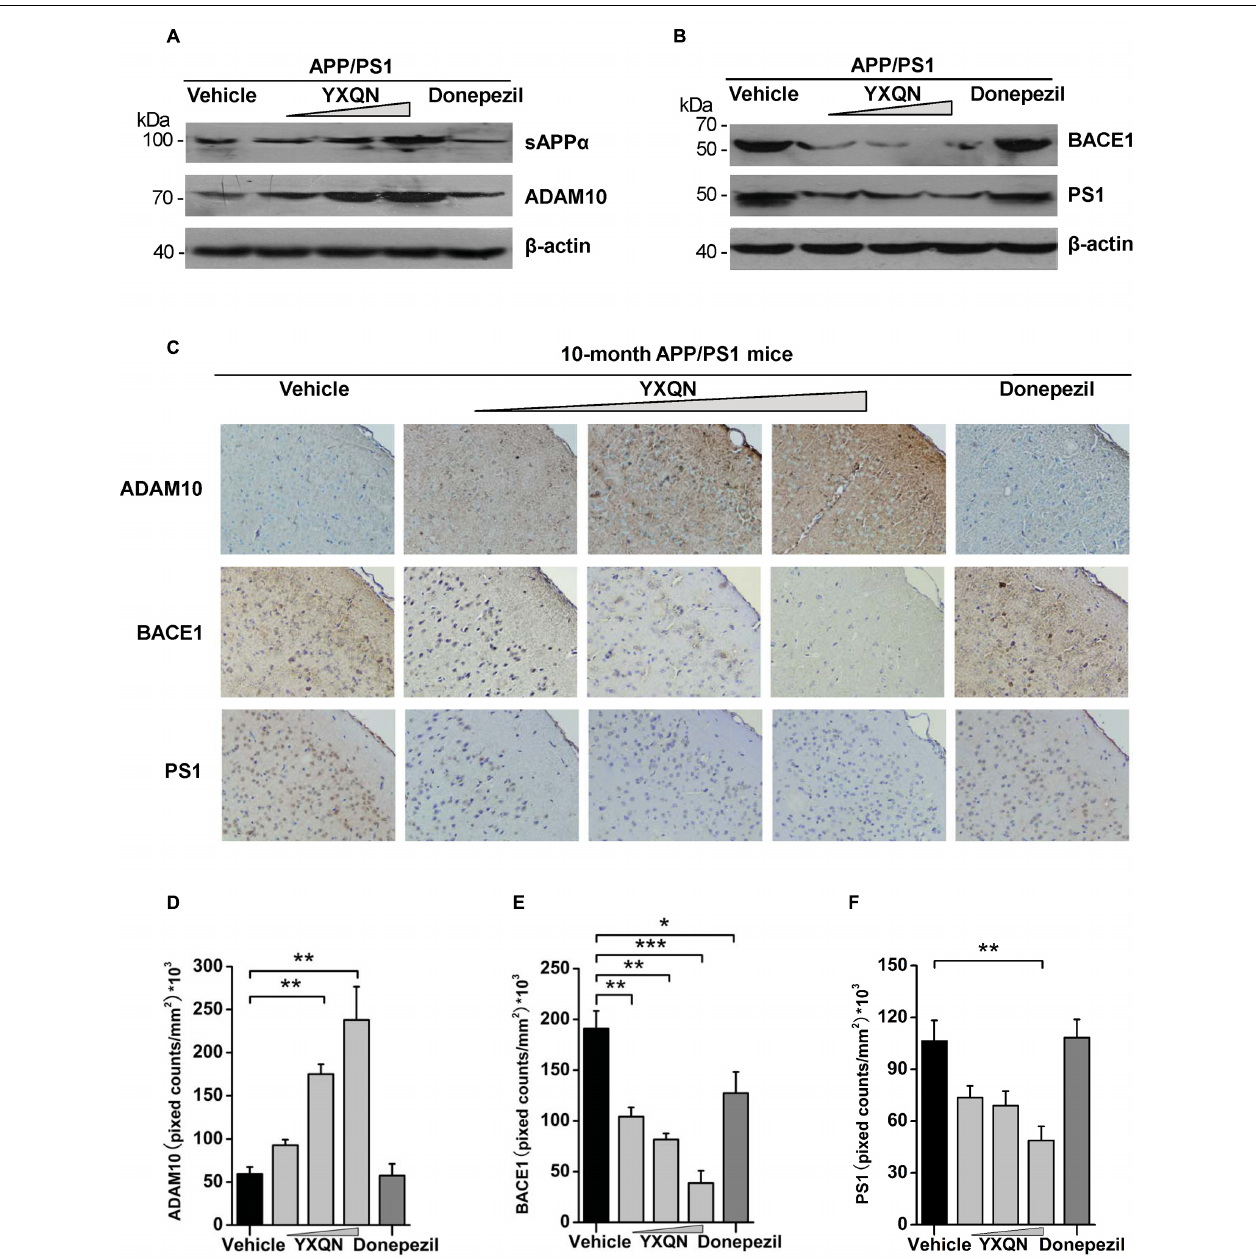
FIGURE 7 | The action of YXQN activates sAPP α and ADAM10, and inhibits BACE1 and PS1 expression demonstrated by Western blot and immunohistochemistry. (A) Immunoblot analysis of α -cleavage product sAPP α and α -secretase (ADAM10) in the brain homogenates of 10-month-old APP/PS1 mice with vehicle, YXQN or donepezil administration. (B) BACE1 and PS1 from mouse brains were subjected to immunoblot analysis. Western blot images of at least three independent experiments are shown ( n = 6 mice per group). (C) Staining for ADAM10, BACE1, and PS1 using specific antibody in sagittal sections of brain, and quantified by pixed counts ( n = 6). The drug dosages from low to high of YXQN extract are 0.69, 2.08, and 6.24 g/kg. Mean ± S.E.M. ANOVA with Dunnet’s post hoc analysis was used (D–F) . ∗ p < 0.05, ∗∗ p < 0.01, and ∗∗∗ p <